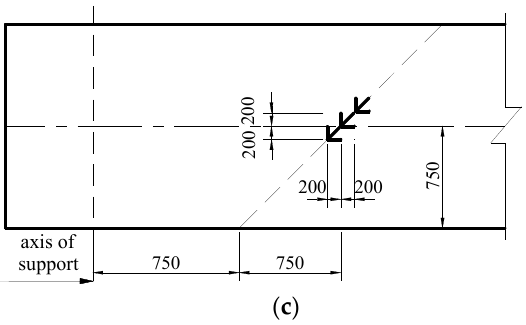
Figure 6. Layout of measuring points: ( a ) Schematic of testing Instrumentation (unit: mm); ( b ) detail of reinforcement strain measuring points; ( c ) schematic of rosette strain gauges.